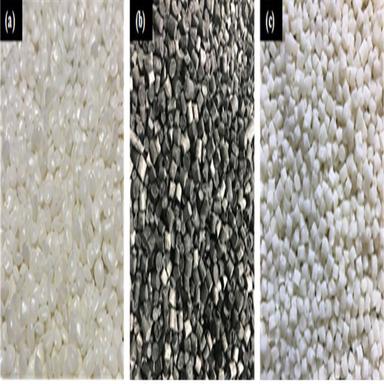
ABS and short fiber-reinforced composite pellets (a) neat ABS, (b) ABS/CF, and (c) ABS/GF.